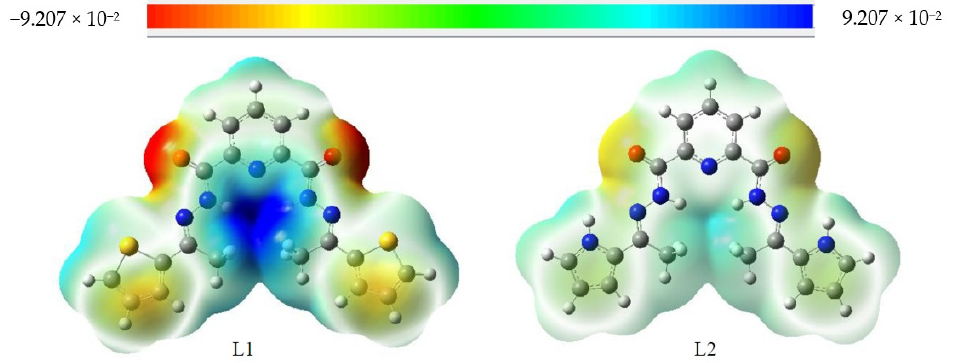
Figure 5. Calculated electrostatic potential surfaces of L1 and L2 generated by B3LYP/6-311G+(d,p). Molecular surfaces were plotted at an electron density of 0.002 e − /bohr 3 . Table 5. Diameter of inhibition zones (mm) of the synthesized compounds, ceftriaxone and amphotericin-B against tested bacterial and fungal strains.